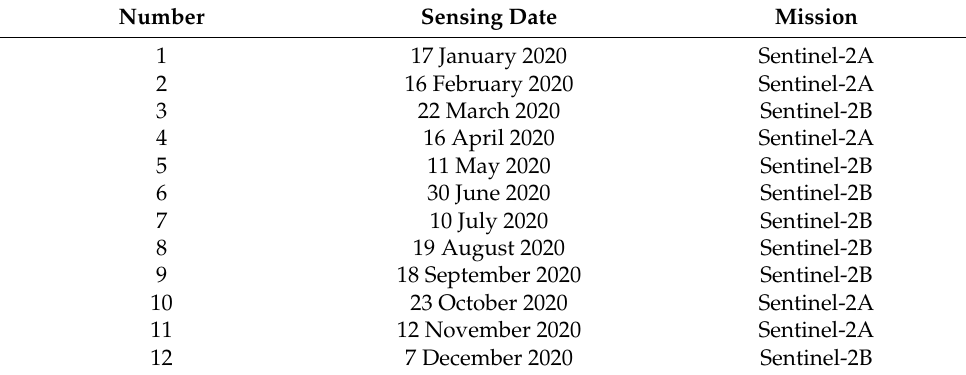
Table 1. Acquisition date of the Sentinel-2A/B satellite images used during 2020 in Lake Tana. Acquisition time ~07:50 am is referenced in Coordinated Universal Time